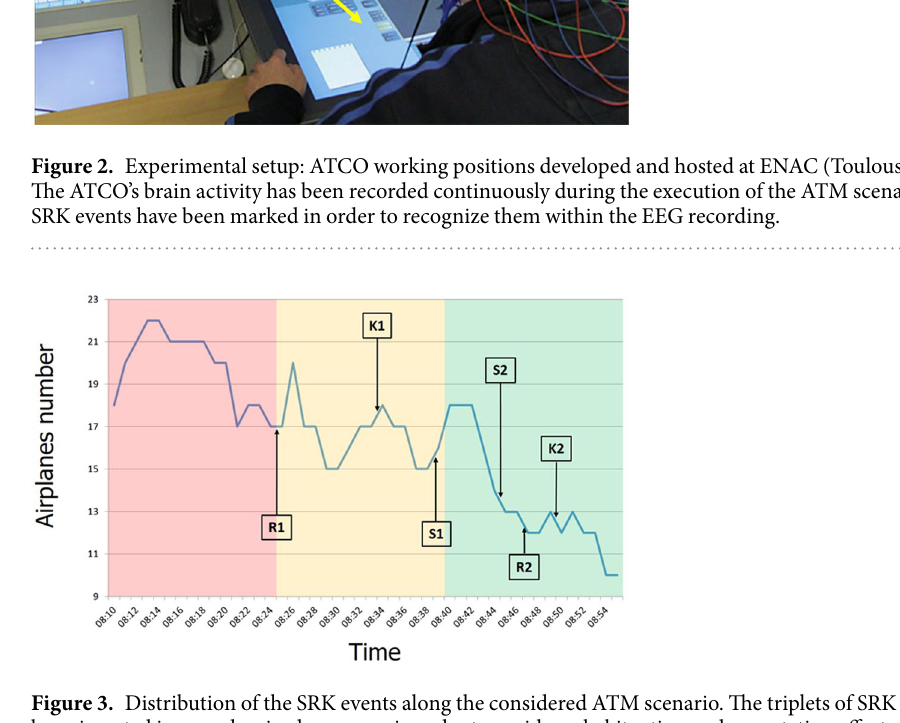
Figure 3. Distribution of the SRK events along the considered ATM scenario. The triplets of SRK events have been inserted in a randomized sequence in order to avoid any habituation and expectation effects. No SRK events have been inserted in the Hard condition in order to do not generate unrealistic ATC